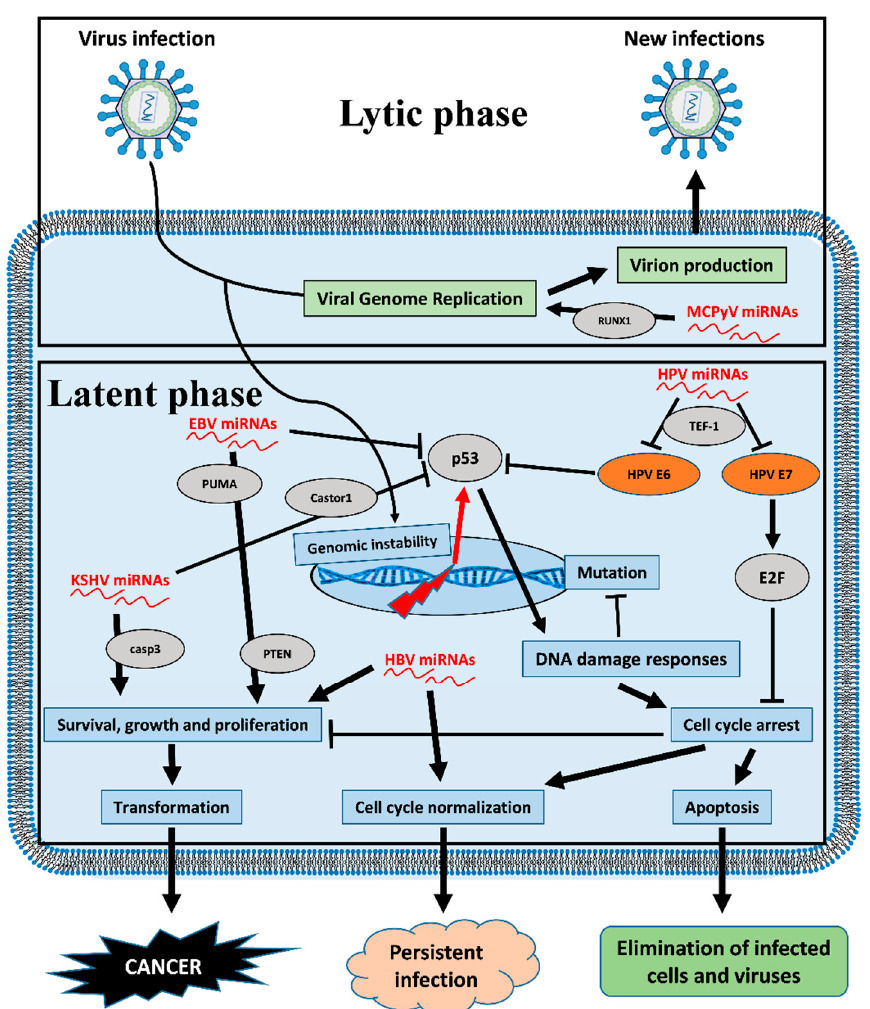
Figure 3. Viral miRNAs affect the pathways involved in the carcinogenesis of host cells. The picture depicts changes to cellular fate because of viral miRNAs. Genomic instability due to viral infection can induce activation of the p53 pathway, which in turn supports both DNA damage responses and cell cycle arrest. In relation to viral infection context, viral miRNAs can affect abortive cell fates such as programmed cell death with consequent cancer transformation. Arrows signify that the factor or process promotes the effect it points to, while blocking arrows signify inhibition. Orange ellipses represent viral proteins, grey ellipses represent host cell proteins, green boxes represent stages of the lytic phase of viral life cycle and blue boxes represent cellular processes affected by viral miRNAs during the viral latent phase.